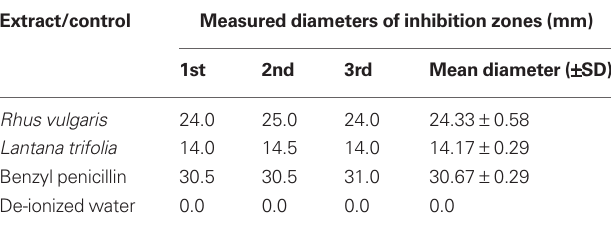
Table 2 | Inhibition diameters of the 50-g extracts of Rhus vulgaris and Lantana trifolia against Streptococcus mutans on blood agar at 48 h